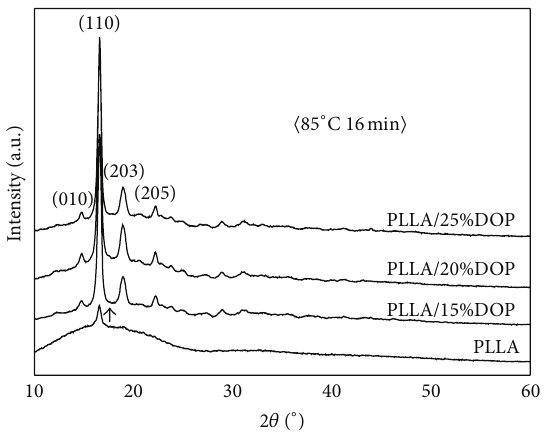
Figure 5: XRD curves of PLLA and PLLA/DOP samples for 16min at 85 ∘ C.